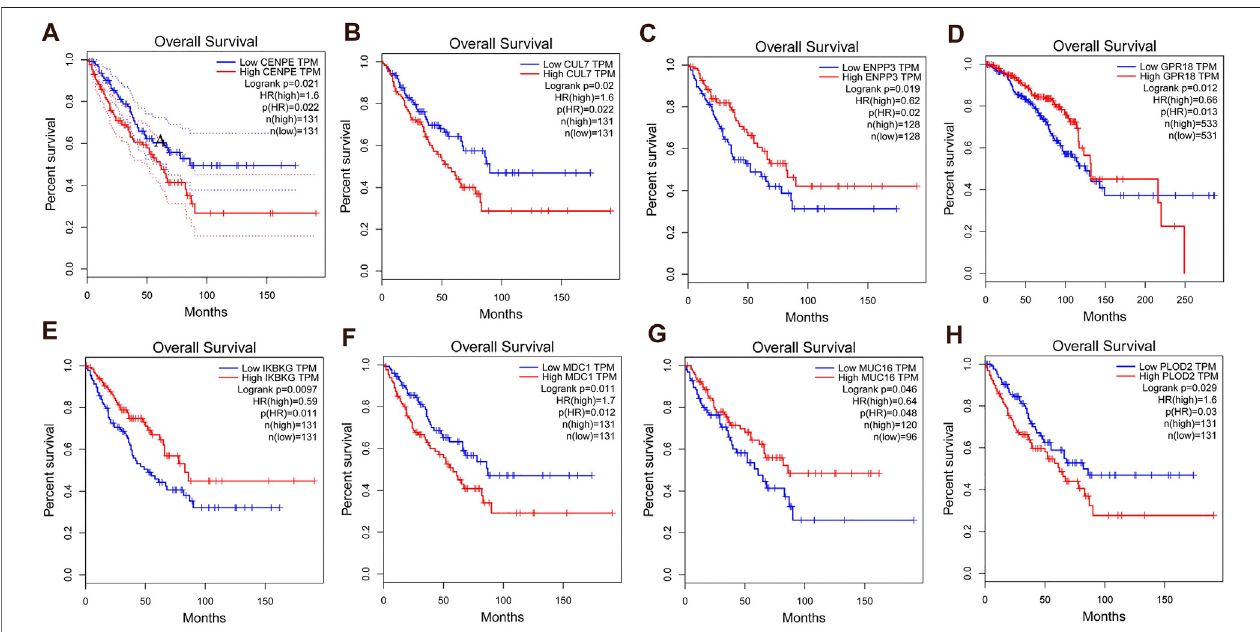
FIGURE4| Theobtained53hubgeneswerefurtherscreenedaccordingtooverallsurvival(OS),andeighthubgeneswerefoundtobehighlyexpressedinsynovial sarcoma tissues. The threshold for prognostic survival signi fi cance was a p- value < 0.05. (A) CENPE; (B) CUL7; (C) ENPP3; (D) GPR18; (E) IKBKG; (F) MDC1; (G) MUC16; (H) PLOD2.